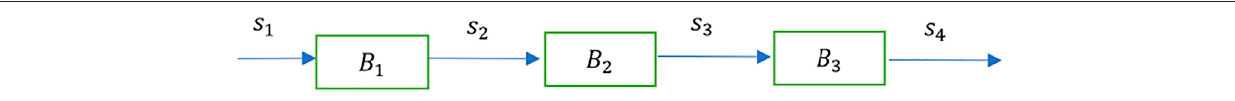
FIGURE 10 | A sheaf containing blocks in series.